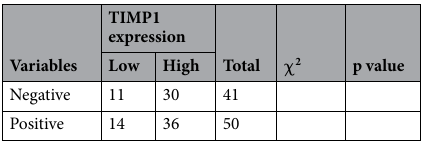
Table 4. The correlation of TIMP1 expression and clinicopathological characters among 94 stomach adenocarcinoma patients. *Fisher’s exact test.